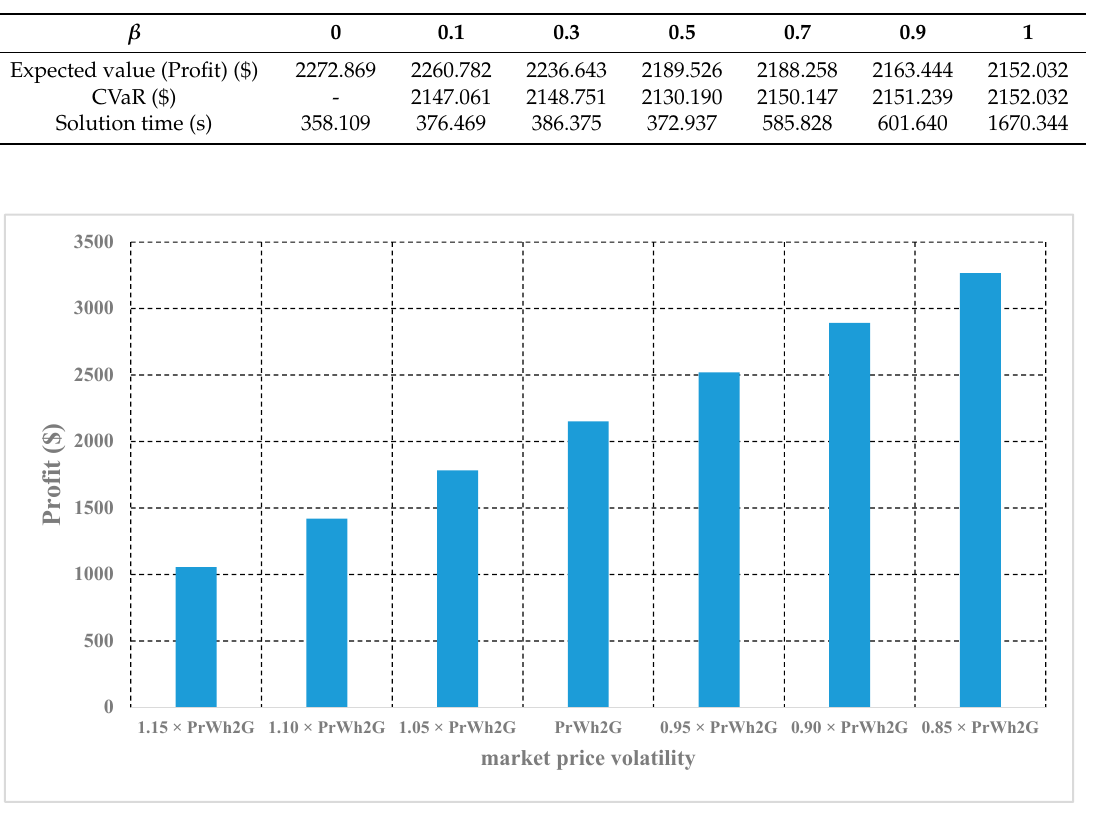
Figure 8. SDISCO ′ s profit in β = 1 by changing of Pr Wh2G . Figure 8. SDISCO’s profit in β = 1 by changing of Pr Wh2G